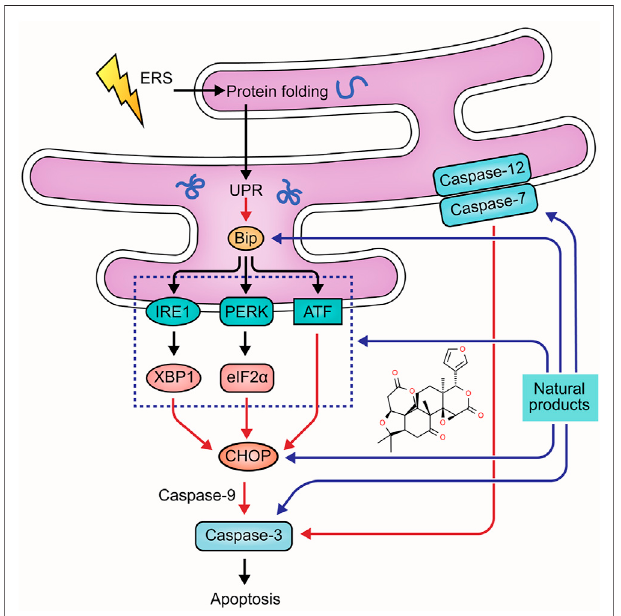
FIGURE 3 | Natural products modulate apoptosis of IECs through ERS- mediated